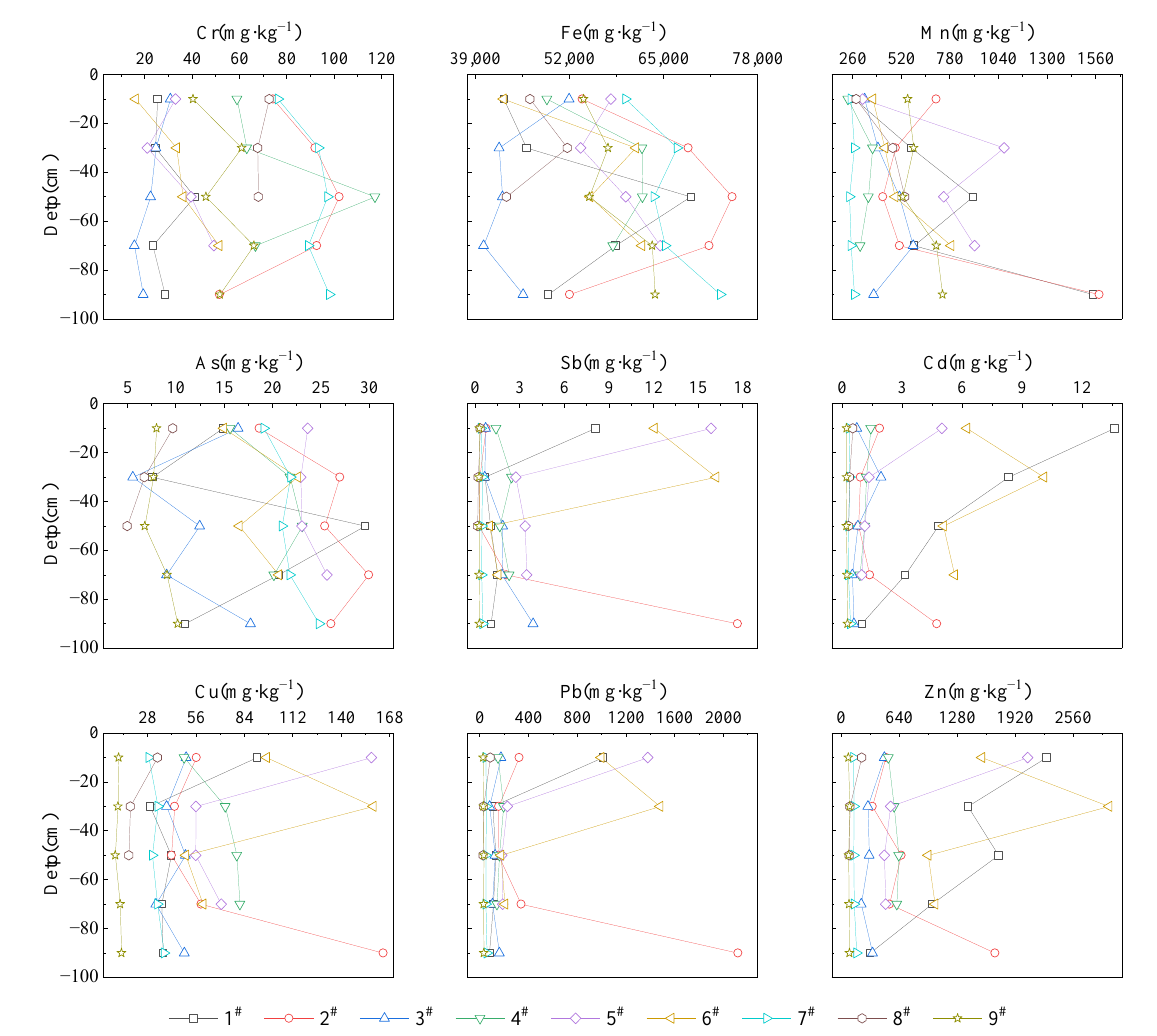
Figure 2. Comparison of HMs content in different sampling points and depths.